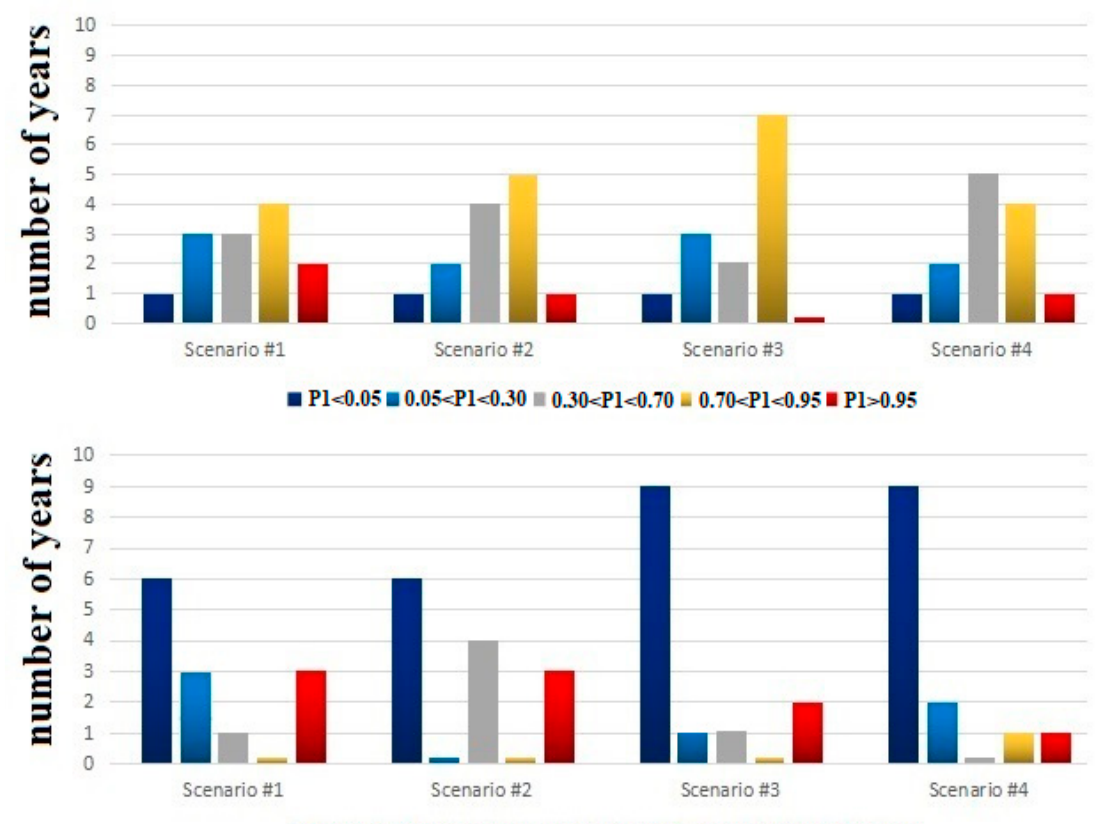
Figure 6. Histograms reporting the number of times the P 1 and P 2 value ranges occur in Tables 1–4 from 2008–2020. The upper panel does not show any prevailing tendency, which suggests that the seismic activity exists because of the bradyseism. However, the bottom panel shows a strong prevailing tendency toward P 2 ≤ 0.05 (blue) that increases from scenario #1 to scenario #4, which suggests that the seismic swarms are mostly linked to rainfalls. The results indicate that wet days enhance the seismic activity in the Phlegraean Fields.